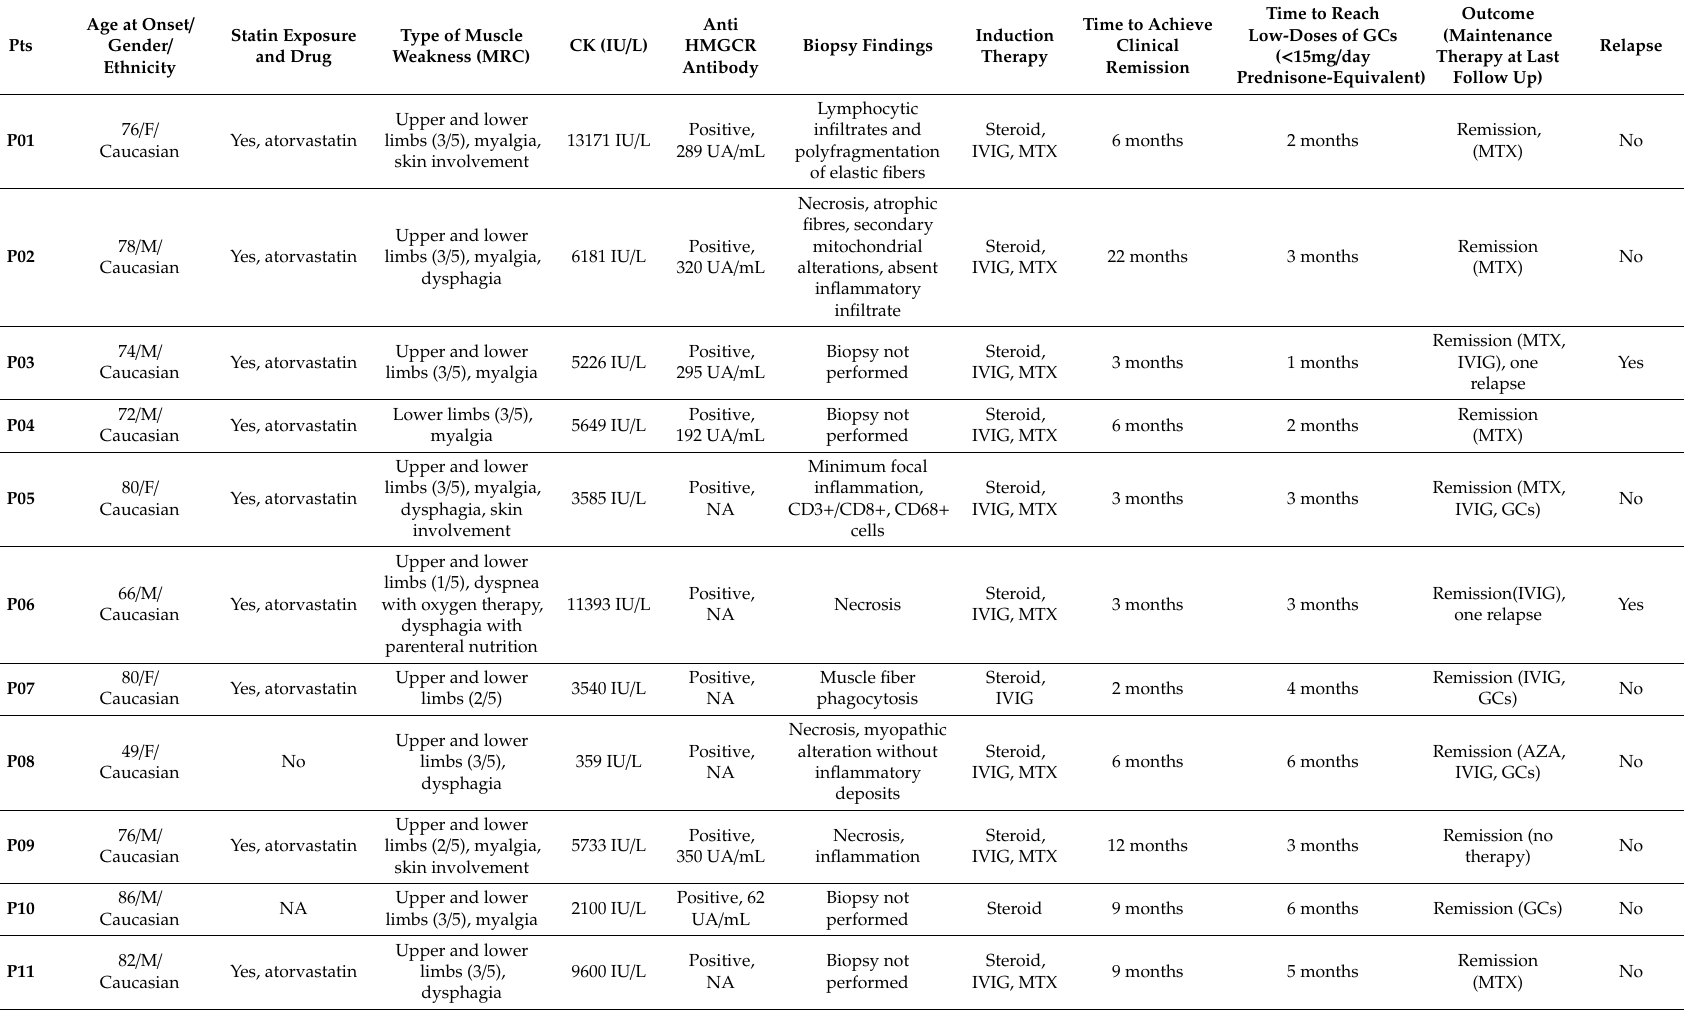
Table 1. Demographic features, clinical presentation, laboratory parameters, management and outcome of patients with anti-HMGCR myopathy ( n =